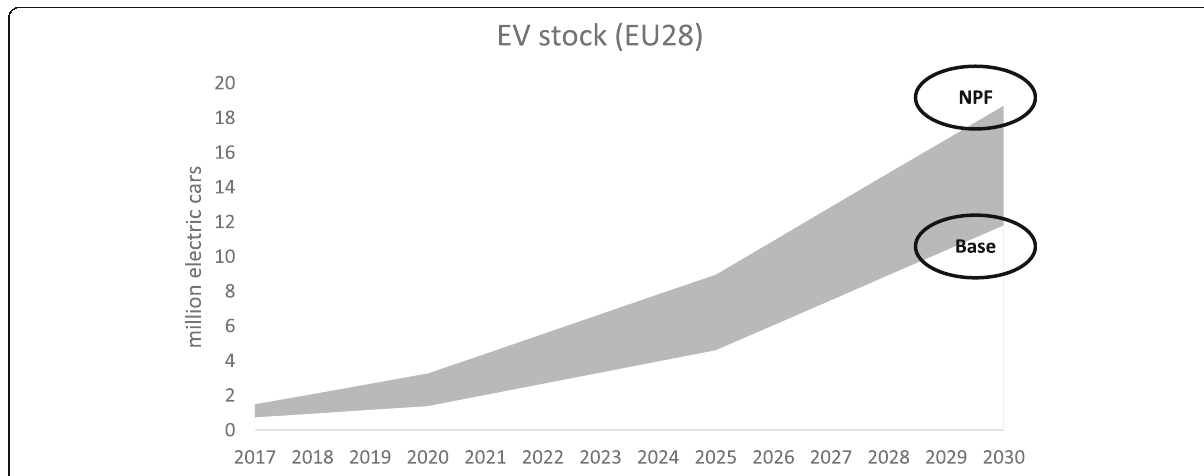
Fig. 4 EV stock (EU28), spread between base and NPF